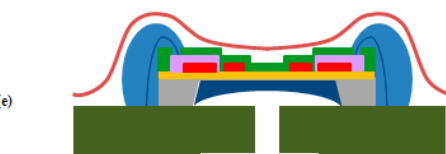
Figure 6. Flowchart for designing protective coatings. ( a ) KOH wet etching; ( b ) Polymer back side molding; ( c ) Chip attach (PCB) and wire bonding; ( d ) Epoxy molding; ( e ) Surface coating.